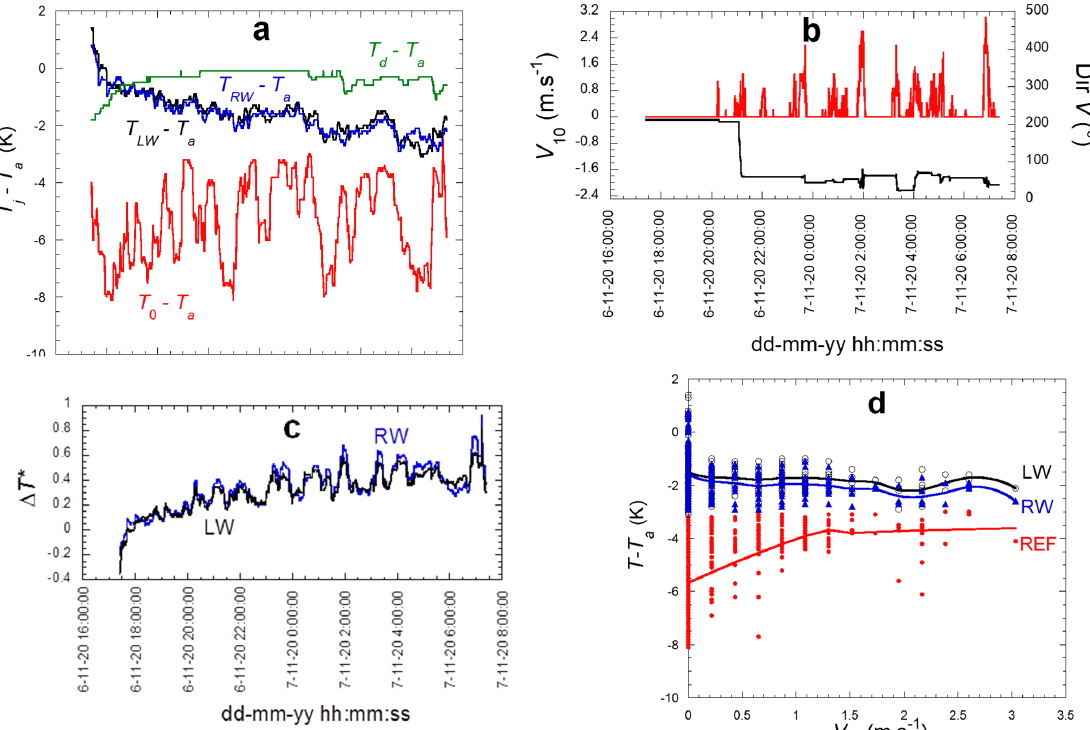
Figure 8. Recorded data for the reference condenser ( T 0 ) and left and right windows on the AD car for the night 6–7 November 2020 (hh:mm:ss, UT + 1) in Ajaccio. ( a ) Differences with air temperature T a of the temperatures of reference ( T 0 ), left ( T LW ), and right ( T RW ) windows. ( b ) Corresponding windspeed V and wind direction Dir V . ( c ) Cooling efficiency ratio ∆ T ∗ and ∆ T ∗ (left and right windows, respectively). ( d ): Left and right window cooling with respect to air temperature ( T LW,RW − T a ) as a function of windspeed V 10 extrapolated at 10 m from the ground. Curves are smoothing functions. During this night, dew yields were (REF) h REF = 0.265 mm.day − 1 , (LW) h LW = 0.039 mm.day − 1 and (RW) h RW = 0.043 mm.day − 1 , corresponding in the visual scale to n = 3 ( ≈ 0.17 mm.day − 1 using the factor 0.056 mm.day − 1 from Section 4.3.4).